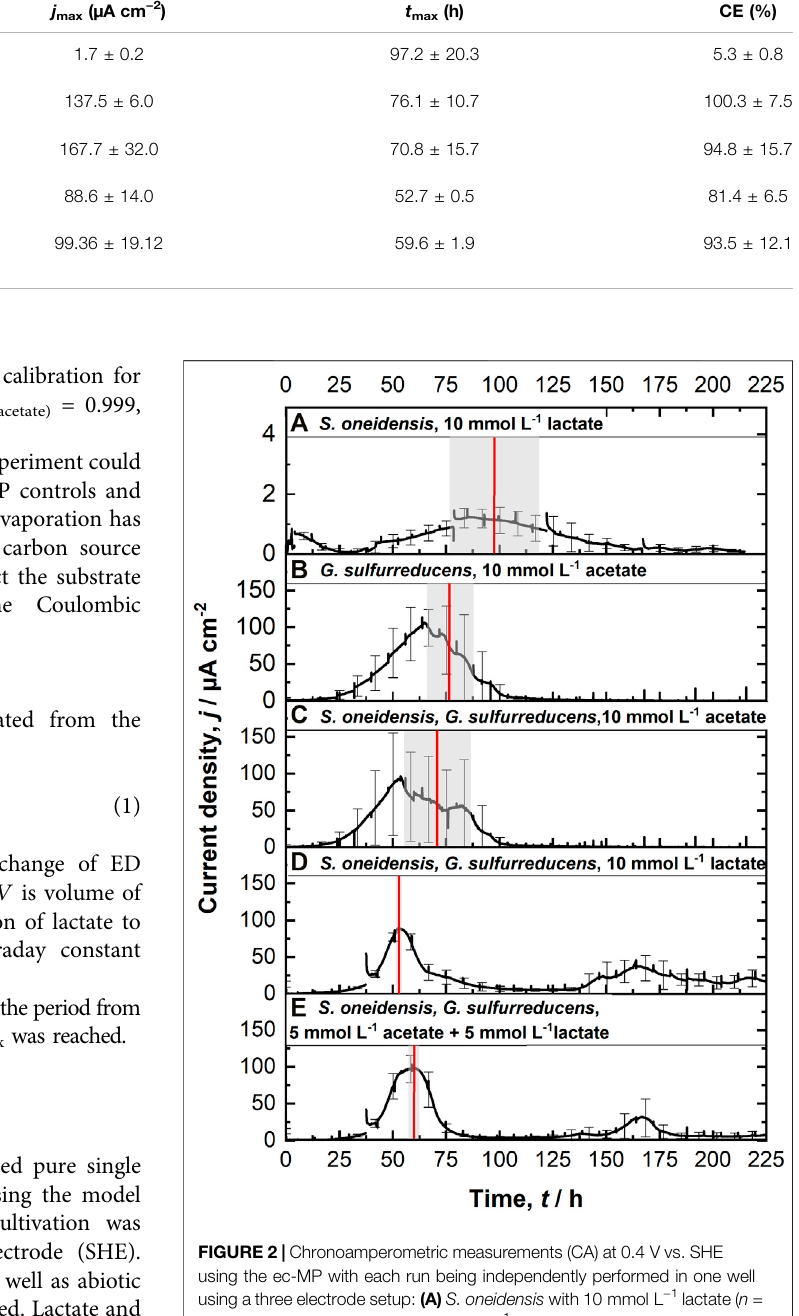
TABLE1| Maximumcurrentdensity( j max )andthetimewhen j max isreached( t max )aswellascoulombicef fi ciency( CE )(mean±sd):(A) S.oneidensis with10 mmol L − 1 lactate ( n = 8); (B) G. sulfurreducens with 10 mmol L − 1 acetateasED ( n = 8), as well asco-cultivations of S. oneidensis and G. sulfurreducens with (C)10 mmol L − 1 acetate( n = 10), (D) 10 mmol L − 1 lactate ( n = 8), and (E) 5 mmol L − 1 lactate + 5 mmol L − 1 acetate as ED ( n = 8). Microorganism